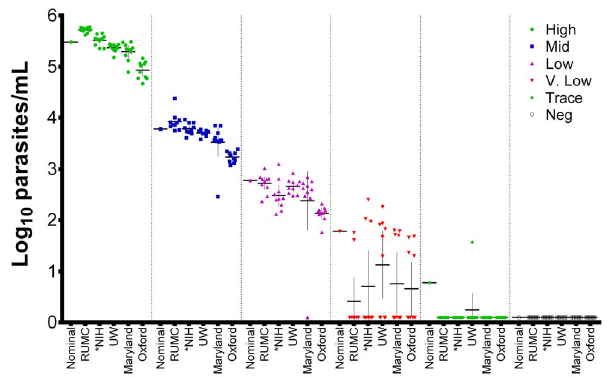
Figure 1. Study data. Results were plotted on a log 10 parasites/mL scale for the five participating laboratories; bars show the mean and 95% confidence interval. Nominal (expected) values for all samples are plotted as follows: high (300,000 parasites/mL or 5.48 log 10 parasites/ mL); mid (6,000 parasites/mL or 3.78 log 10 parasites/mL); low (600 par- asites/mL or 2.78 log 10 parasites/mL); very low (60 parasites/mL or 1.78 log 10 parasites/mL), trace (6 parasites/mL or 0.78 log 10 parasites/ mL) and negative (no parasites). Samples with no parasites detected were plotted as 0.1 log 10 parasites/mL. Two-way ANOVA comparisons across all high, mid and low parasite density samples with